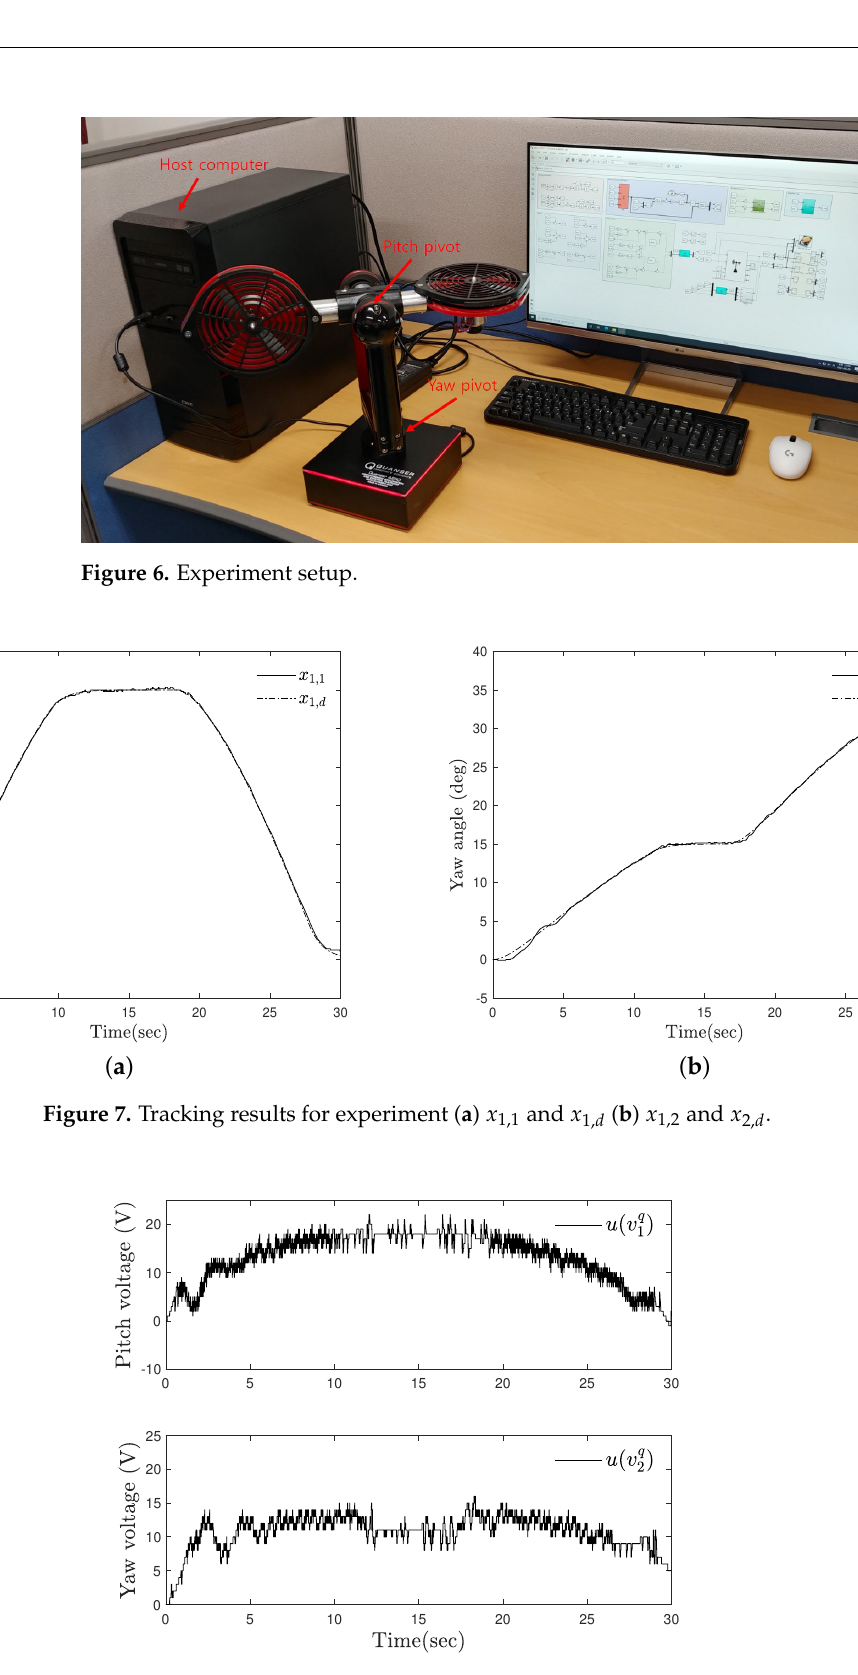
Figure 8. Control input voltage V p and V y for